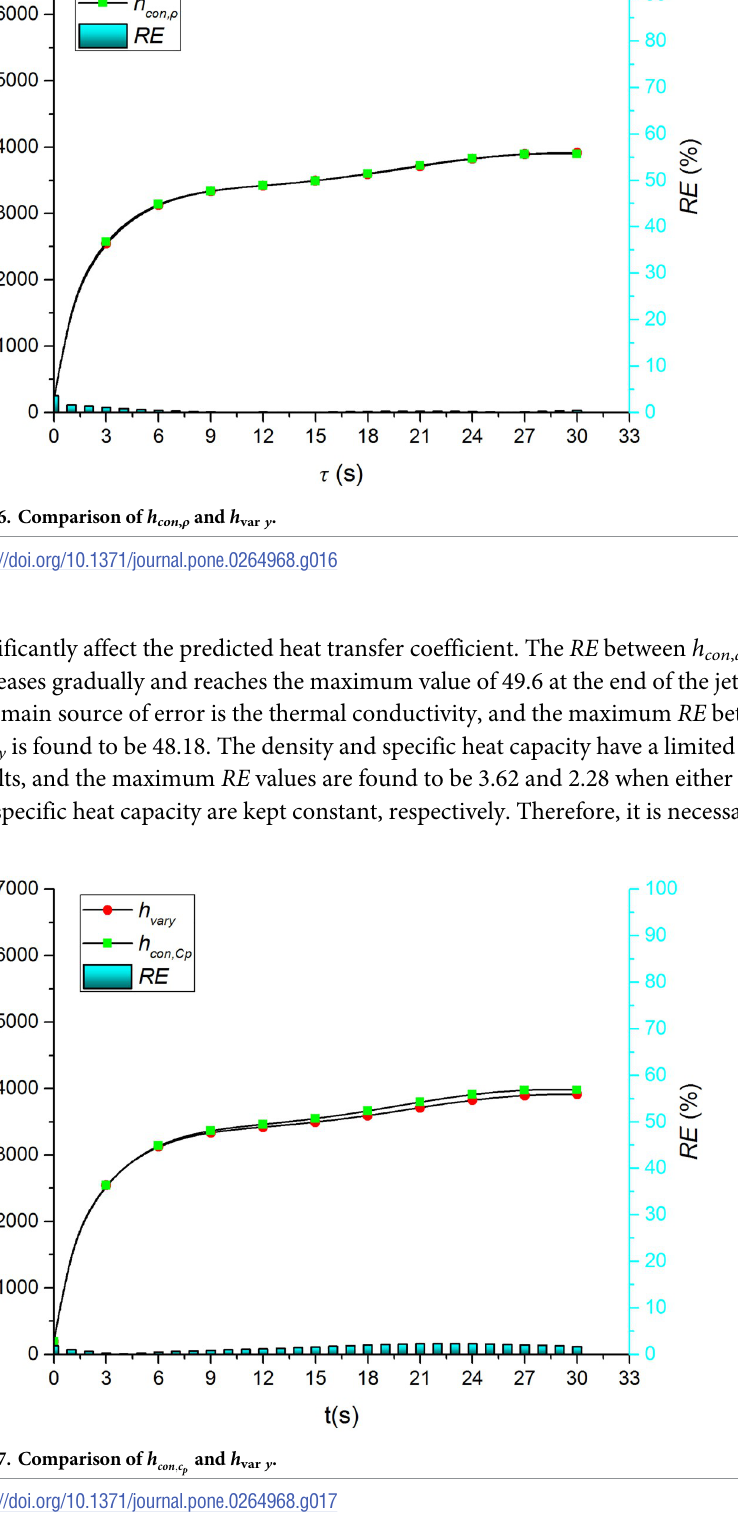
Fig 17. Comparison of h